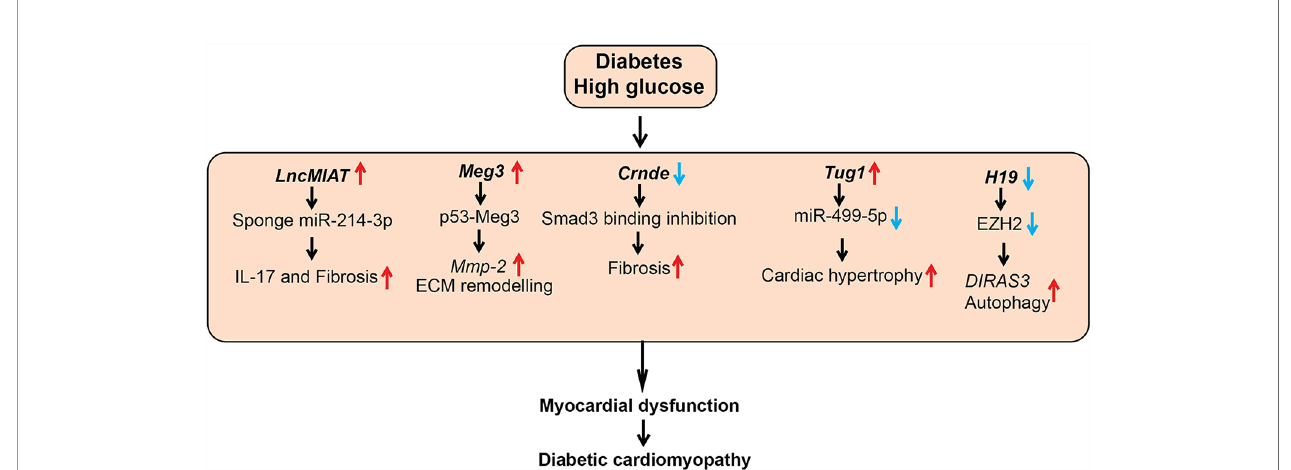
FIGURE 4 | Role of lncRNAs in diabetic cardiomyopathy (DCM). A schematic showing dysregulated function of lncRNAs in the pathogenesis of DCM, such as cardiac hypertrophy, fi brosis, and in fl ammation. Arrows indicate the direction of changes in the expression or function. Mmp-2 , Matrix Metalloproteinase-2; ECM, Extracellular matrix; Smad3, SMAD family member 3; EZH2, Enhancer of Zeste 2 Polycomb Repressive Complex 2 Subunit; DIRAS3, DIRAS Family GTPase